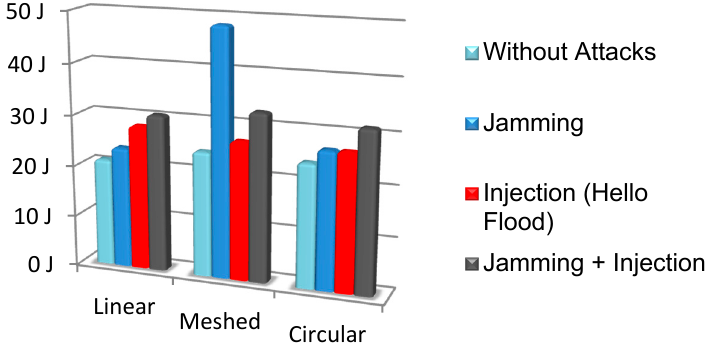
Figure 11. Total Energy consumption.